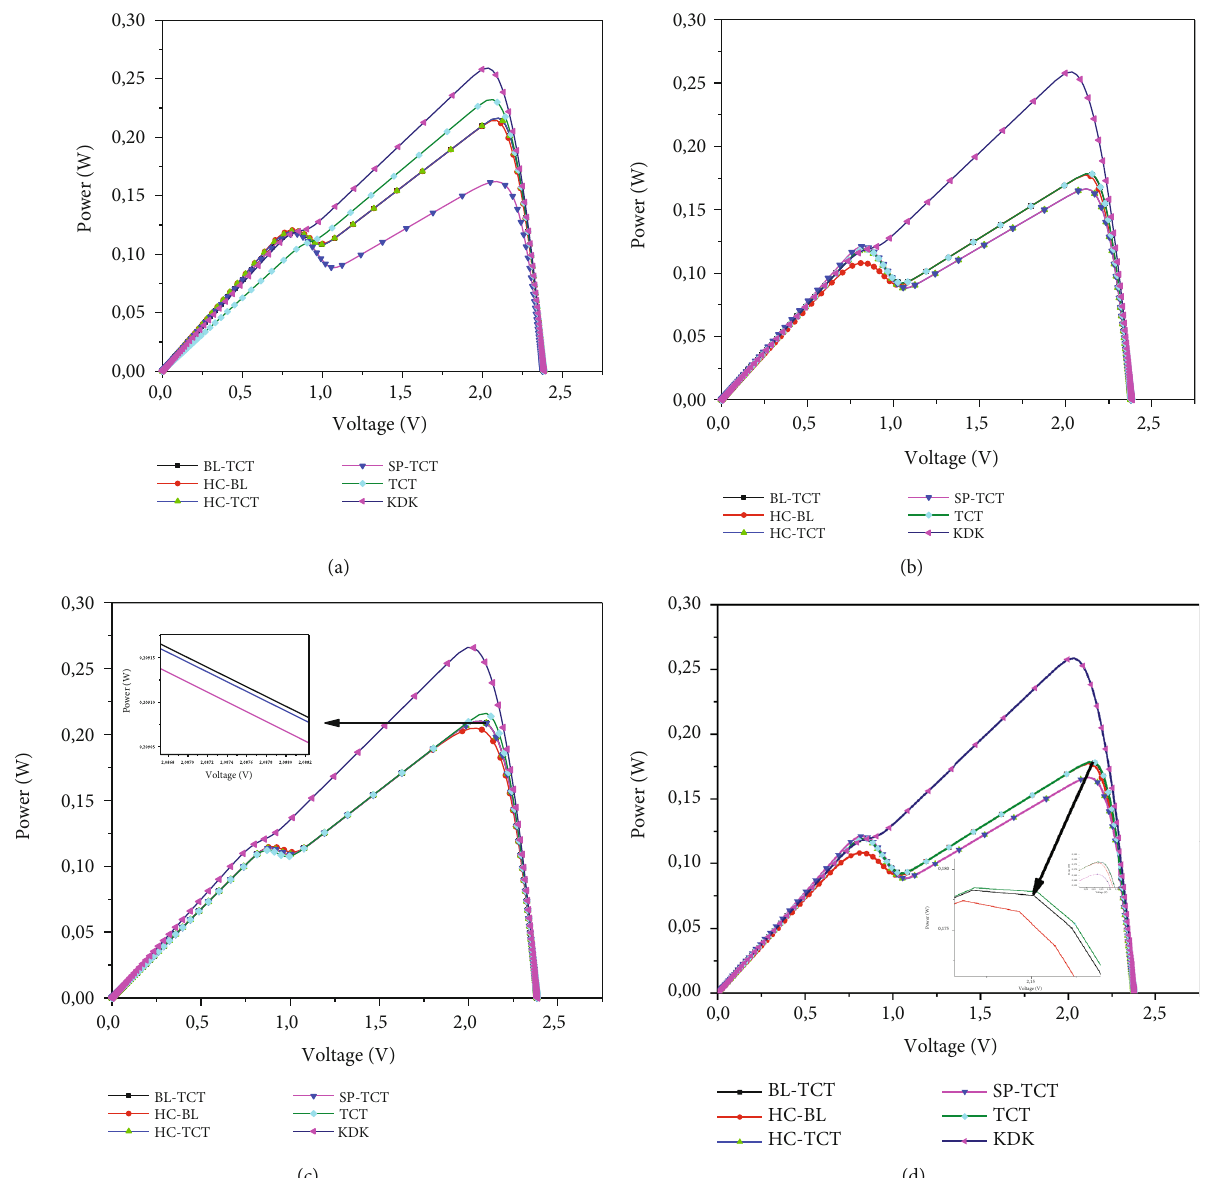
Figure 14: P-V characteristics of various PV module topologies operating in SS-pattern conditions: (a) SS-pattern A, (b) SS-pattern B, (c) SS-pattern C, and (d) SS-pattern